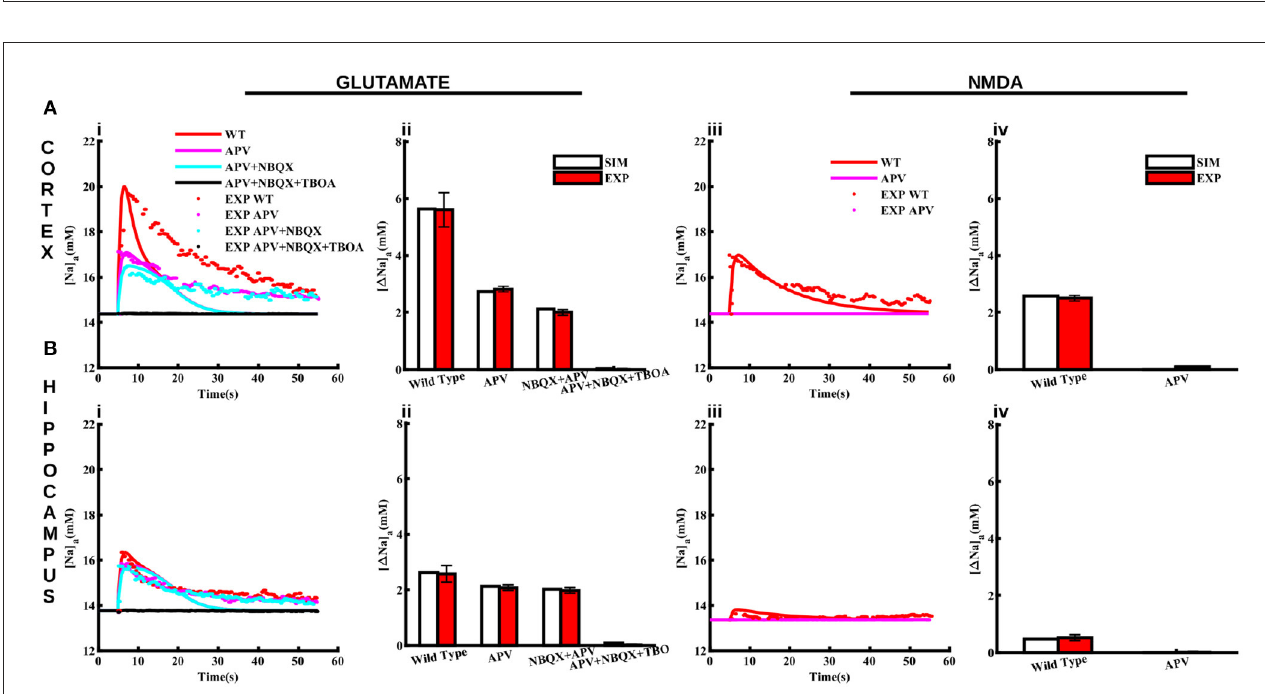
FIGURE4 Pharmacological properties of glutamate and NMDA-induced Na a transients in cortical and hippocampal astrocytes. (A) Changes in Na a in the cortical astrocytes due to 1 mM glutamate applied for 100 ms (Ai) and 0.5 mM NMDA applied for 50 ms (Aiii) in control conditions (WT) and in the presence of APV, NBQX, and TBOA. The bar plots in (Aii, Aiv) represent the peak changes in Na a estimated from the traces in (Ai, Aiii) , respectively. (B) Same as in (A) but for hippocampal astrocytes. Solid lines represent model fits whereas markers are experimental results adapted from Ziemens et al. (2019) for comparison.